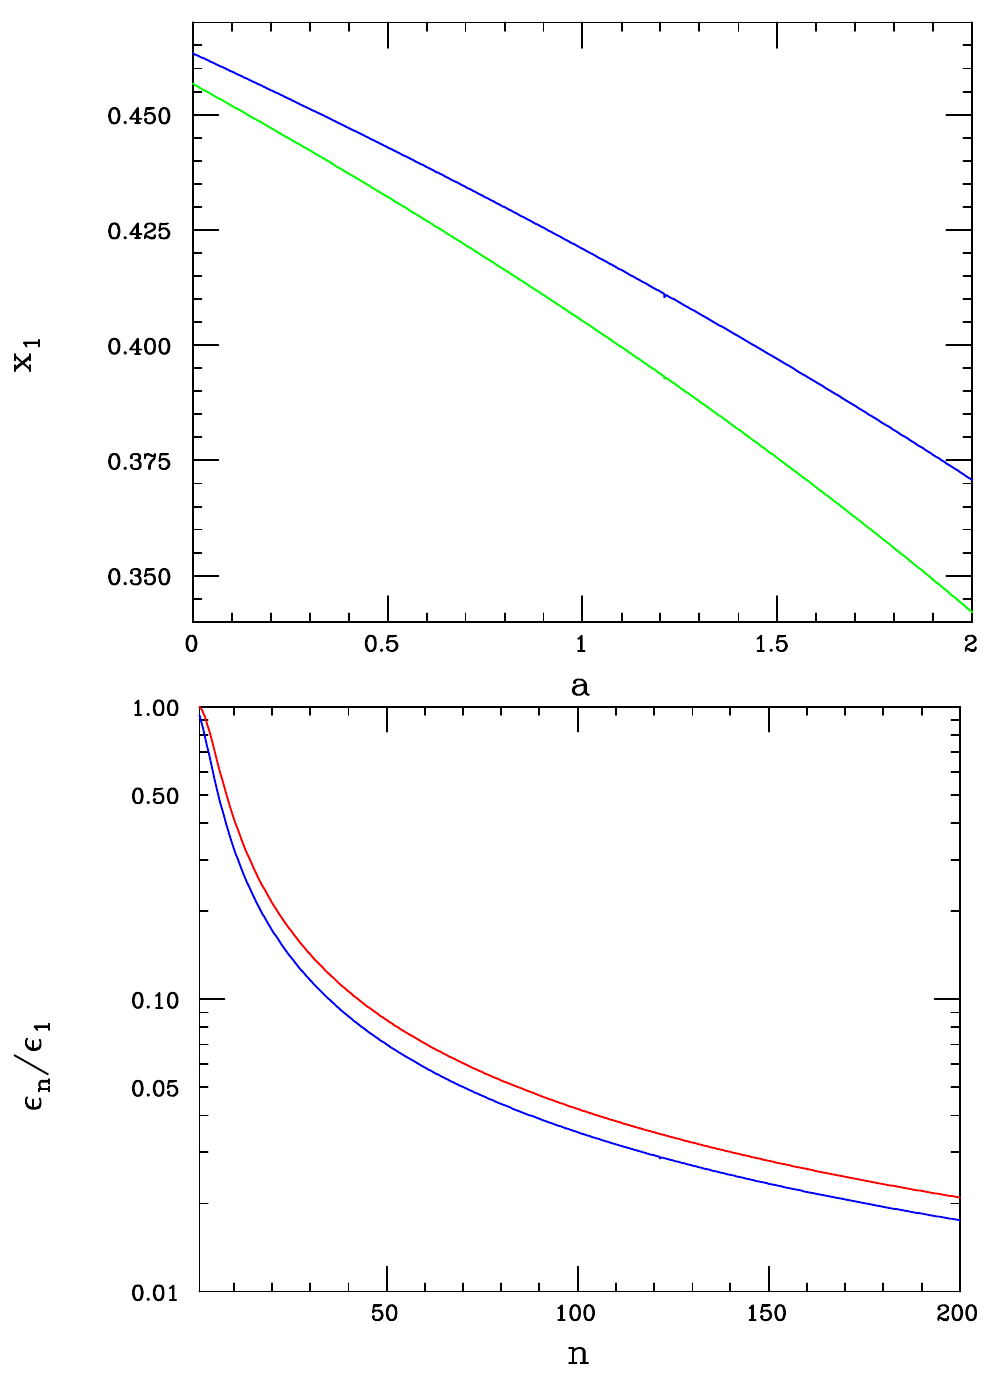
Figure 9 . Top: value of x V as a function of a for (cid:14) A = 0 : 5(upper curve) and 0.6(lower curve), 1 respectively. Bottom: values of (cid:15) n =(cid:15) 1 as a function of n assuming a = 1 for (cid:14) A = 0 : 5(upper) and 0.6(lower), respectively.